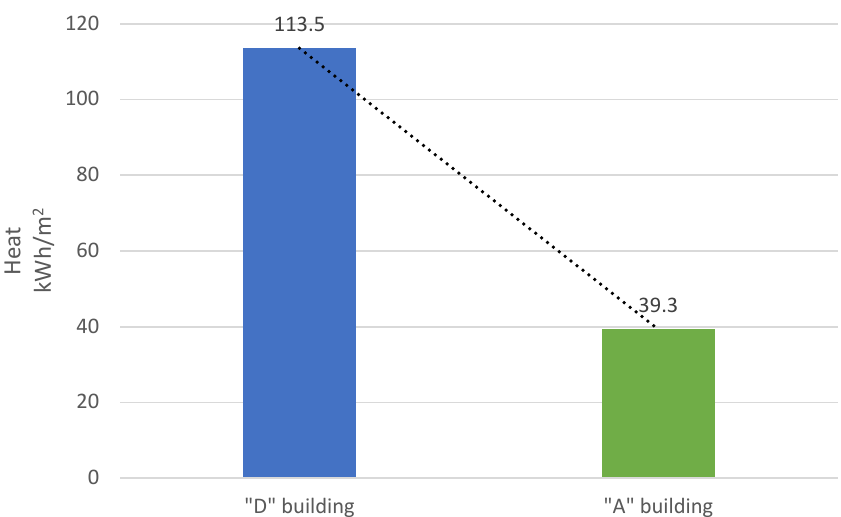
Figure 13. Changes of the U-values caused by building renovation.